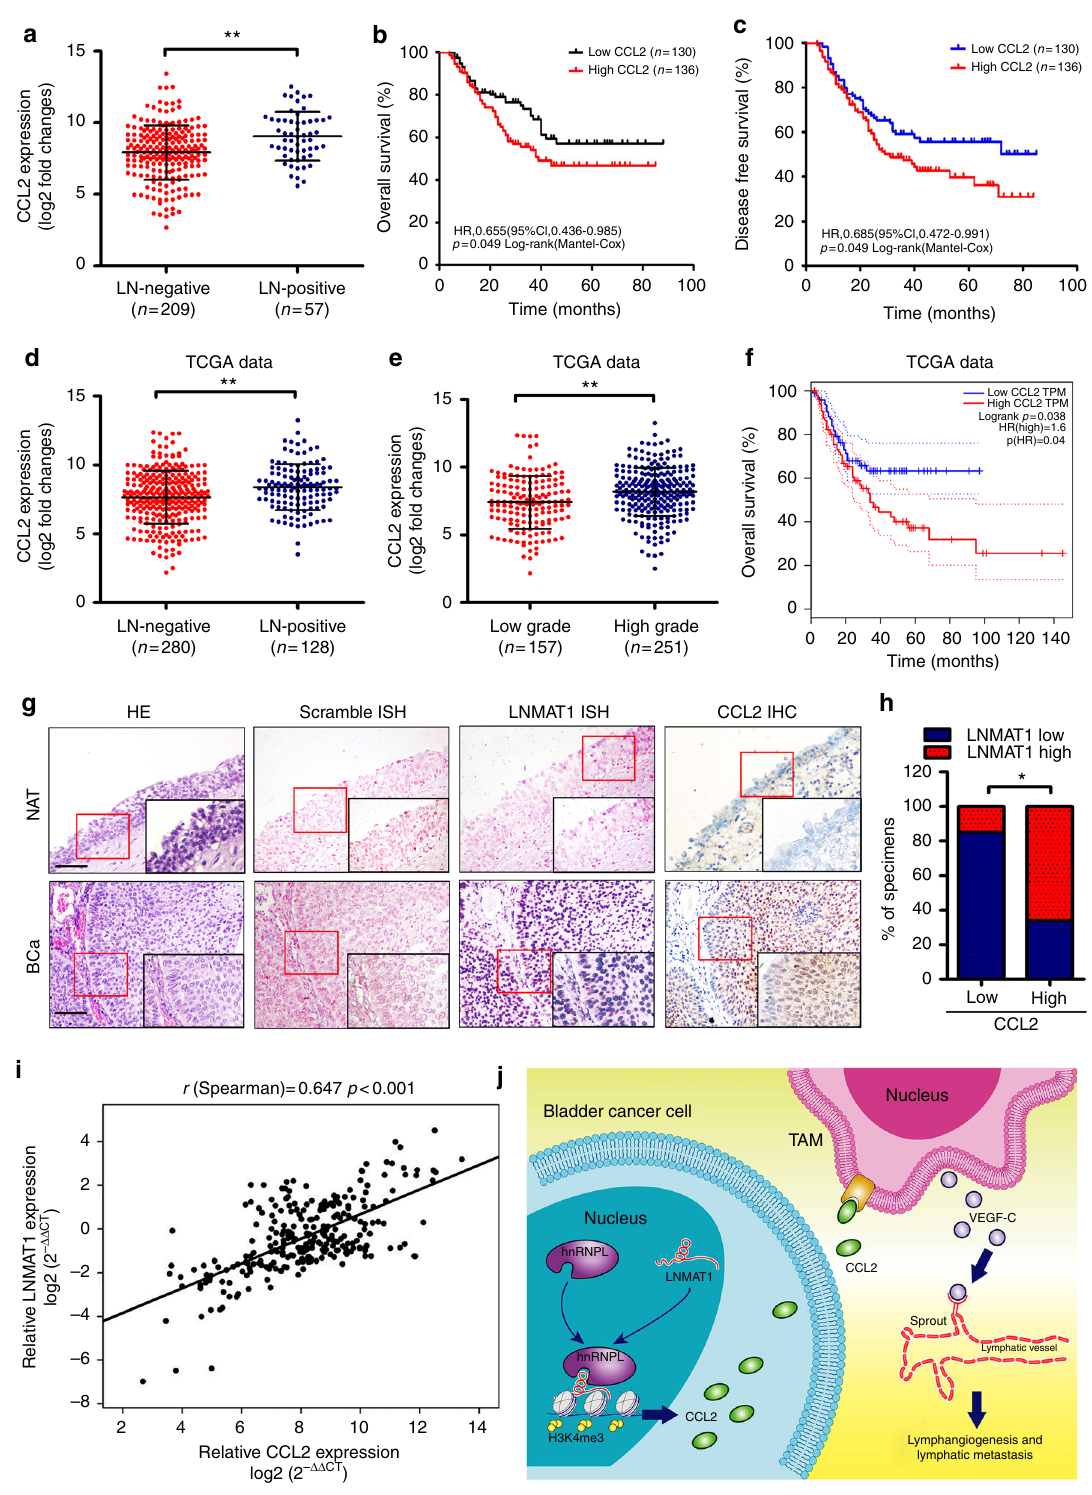
Fig. 9 Clinical relevance of LNMAT1 /CCL2/lymphangiogenesis in bladder cancer. a Correlation of CCL2 expression in bladder cancer tissues ( n = 266) assessed by qRT-PCR with LN status. The nonparametric Mann – Whitney U -test was used. b , c Kaplan – Meier analysis for OS and DFS of bladder cancer patients with low vs. high expression of CCL2. The median CCL2 expression was used as the cutoff value. d – f TCGA data showed that LNMAT1 overexpression correlated with LN metastasis ( d ), high grade ( e ), and poor prognosis ( f ). g – h The LNMAT1 levels were positively correlated with CCL2 expression in the bladder cancer specimens ( n = 266; p < 0.001). Scale bars: 100 μ m. Statistical signi fi cance was assessed by χ 2 test. i Correlation analysis of LNMAT1 and CCL2 mRNA expression by qRT-PCR. j Illustrative model showing the proposed mechanism by which LNMAT1 promotes lymphatic metastasis in bladder cancer via CCL2-dependent TAMs recruitment. The error bars represent standard deviations of three independent experiments. * p < 0.05 and ** p <